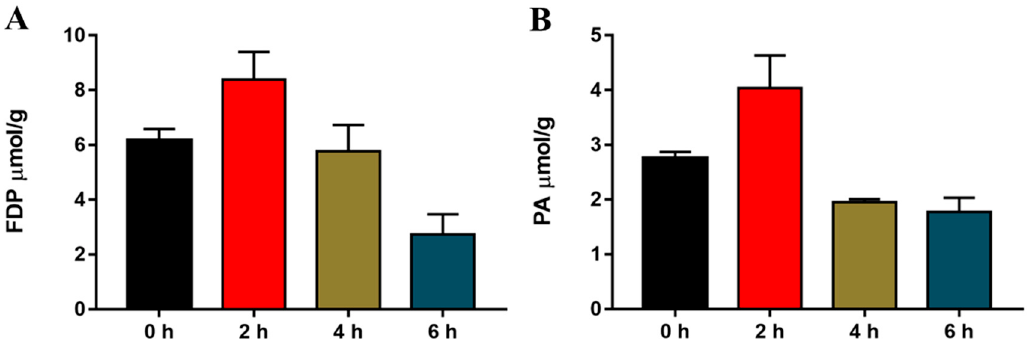
Figure 3. Effect of acute cold exposure on the level of glycolytic intermediates: ( A ) fructose-1,6-diphosphate (FDP) and ( B ) pyruvic acid (PA) in C57BL/6 mouse livers. The data are presented as the mean ± SEM ( n = 8). Statistically significant differences are indicated; * p < 0.05 and ** p < 0.01.